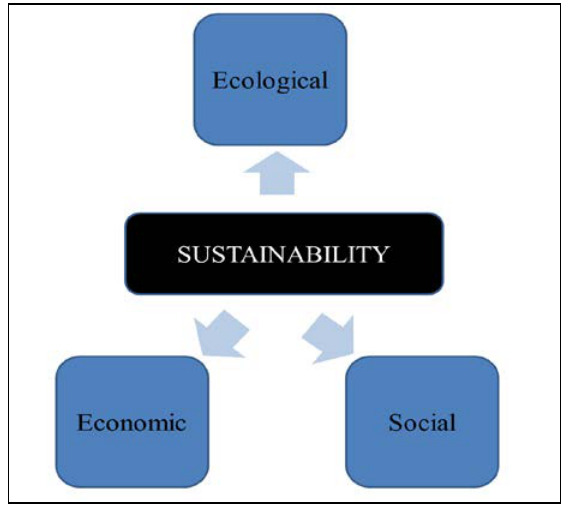
Figure 4. Elements of Sustainability